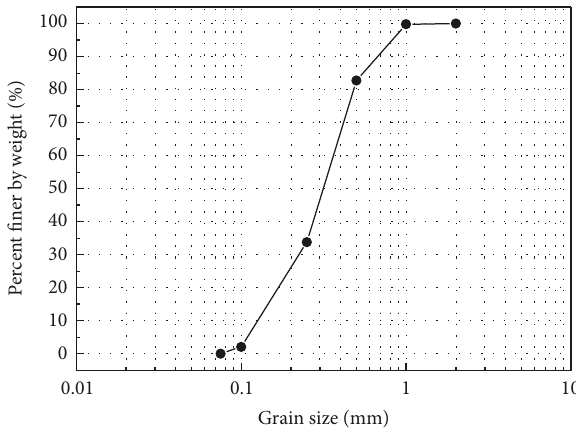
Figure 1: Grain size distribution of sand.